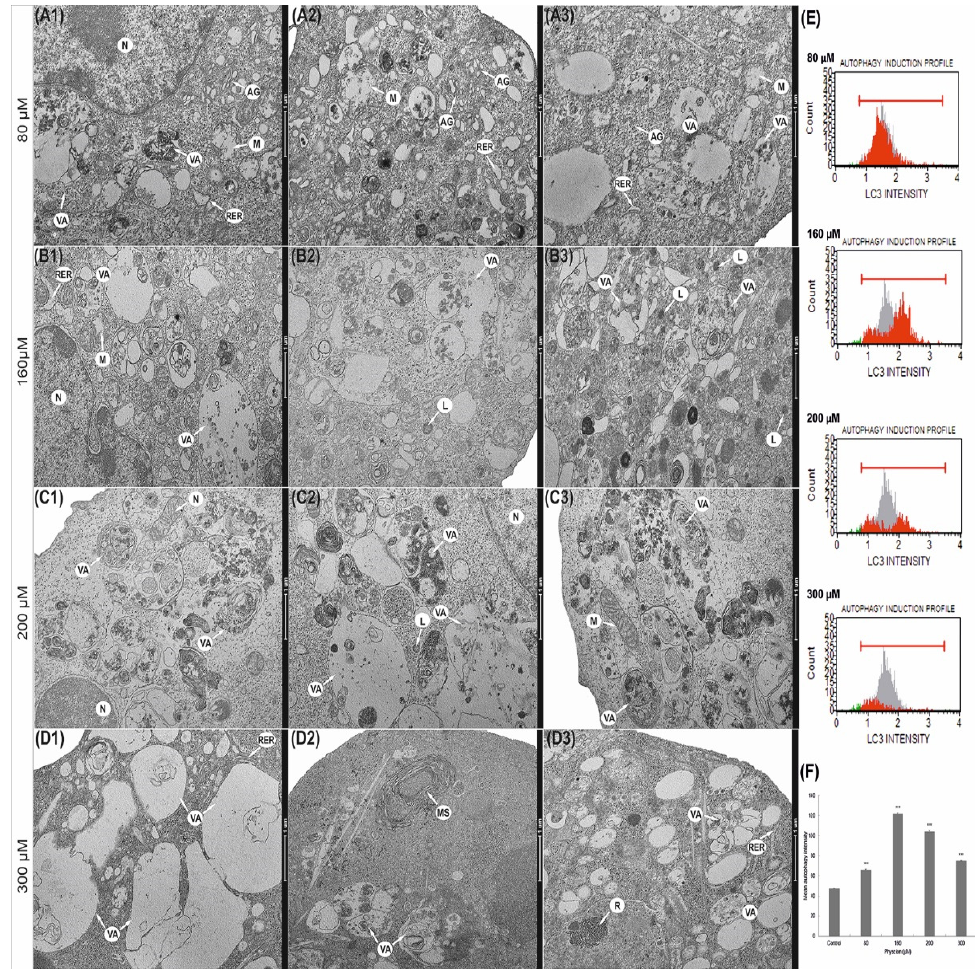
Figure 5. Ultrastructural and biochemical changes in the lysosomal compartment of HeLa cells encumbered with 48 h of physcion action. ( A1 – A3 ) Cells with numerous autophagic vacuoles and swollen cisterns of Golgi apparatus (80 µ M). Cells with intense degradation processes, with numerous autophagic vacuoles and lysosomes (160 µ M) ( B1 – B3 ). Vacuoles at various stages